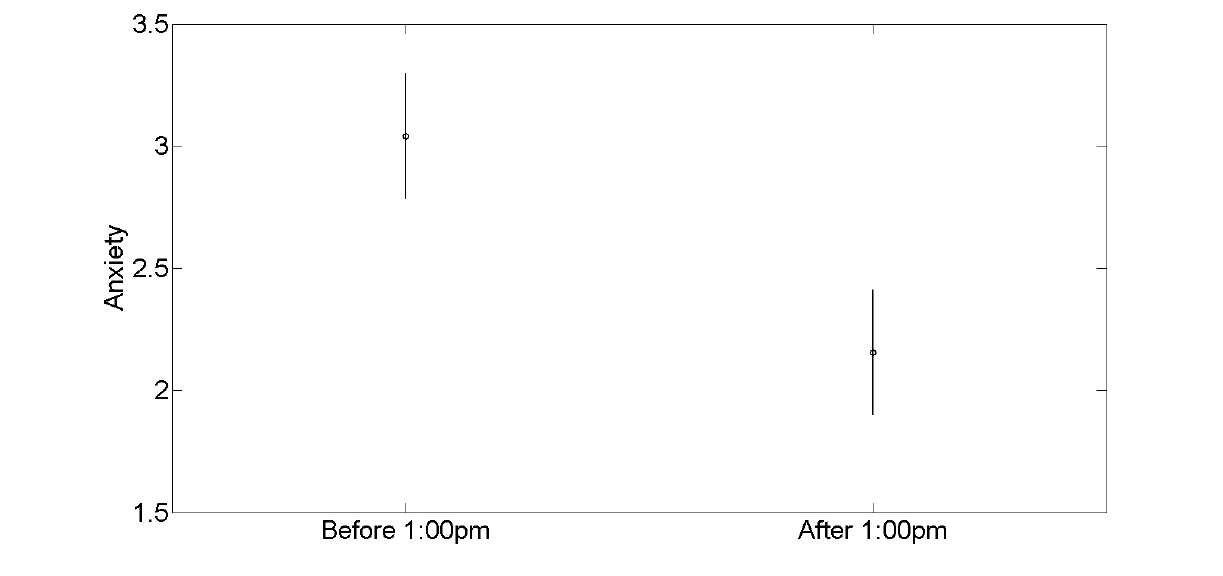
Figure 11. Octavia’s interview accounts of morning procrastination are paralleled in her experience sampling data, which show elevated anxiety before 1:00 PM. The circles show the mean values in the diurnal segments indicated on the abscissa. Error bars show the 95% confidence limits on the